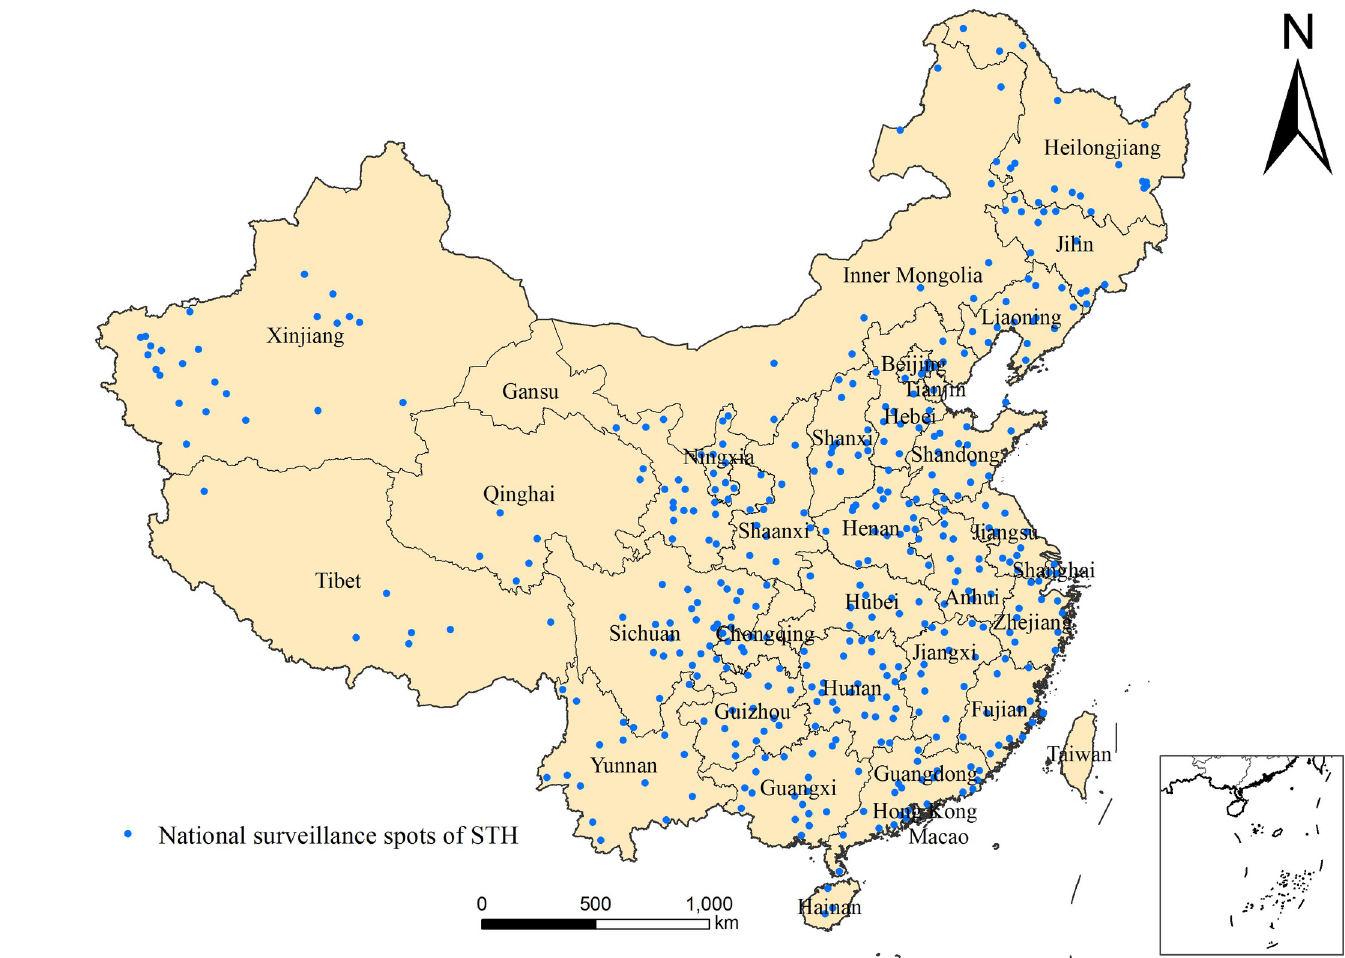
Fig 1. Distribution of national surveillance spots of STH in 2019. (https://www.webmap.cn/mapDataAction.do?method=forw&resType=5&storeId=2&storeName=%